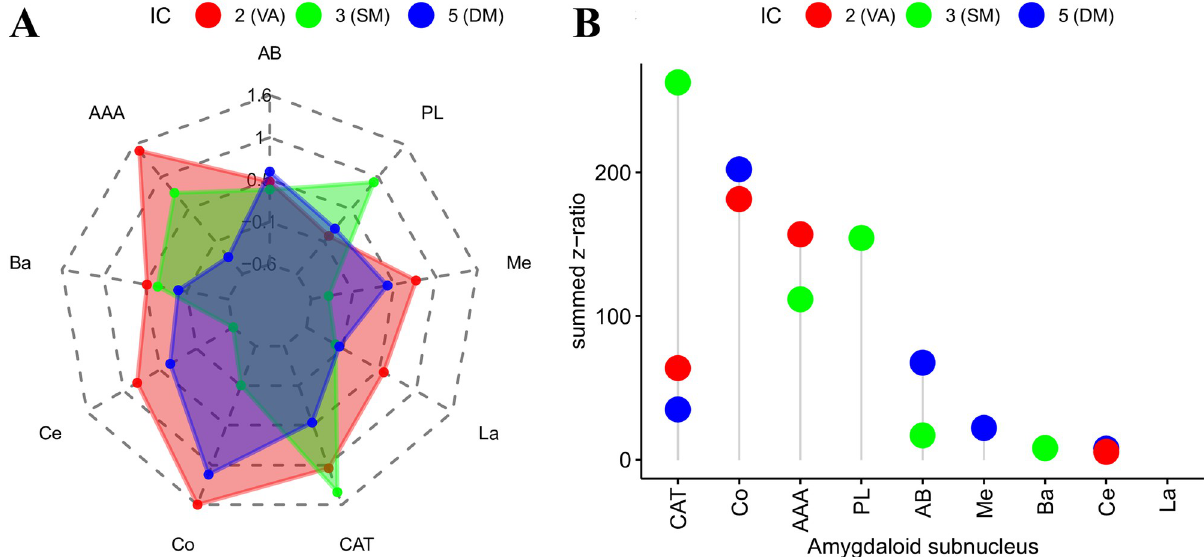
Fig 6. Results from group-level analyses for amygdala nuclei. Estimated marginal mean co-activity values for each amygdaloid nucleus across the three IC hotspots detected in the amygdala (A), as well as the relative contributions of each amygdaloid subnucleus within each IC hotspot in terms of summed group-level pairwise comparisons (B). Note how the different IC hotspots that are associated with different resting-state networks rely on different configurations of subnucleus co-activity.